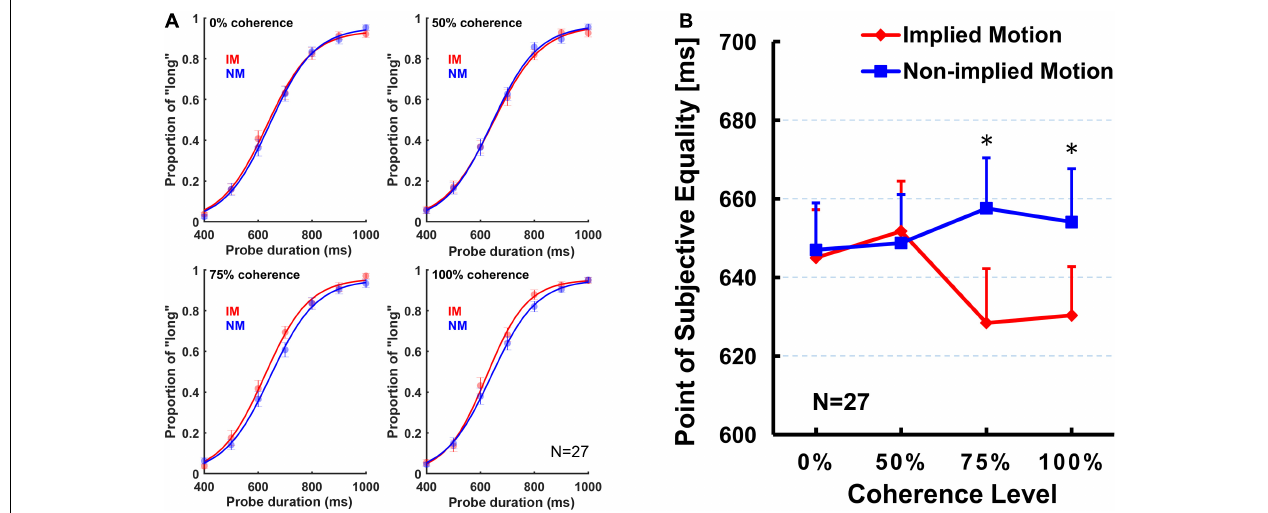
FIGURE 2 | The obtained logistic curves of the “long” responses (A) and mean point of subjective equality (PSE; B ) for each stimulus type and for each coherence level. Error bars represent standard errors of the mean across subjects. Sample size n = 27.